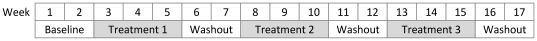
Experimental design used in this study.Subjects (n = 10) participated in a 17-week double-blind crossover design, in which 3 dietary treatments were assessed: 100 g of crackers containing either native starch or 33 g of RS2 or RS4. An initial baseline period was proceeded by 3-week periods of each dietary treatment in succession interspersed by 2-week washout periods, and a final washout period. Weekly fecal samples were collected throughout the entire study.